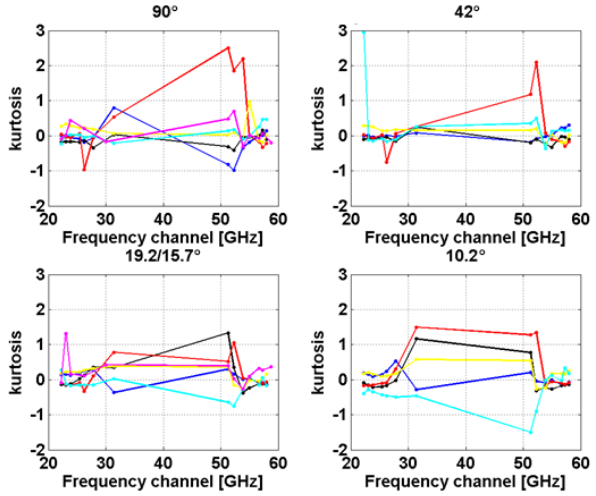
Figure 8. Excess kurtosis as function of frequency for elevation an- gles 90.0, 42.0, 19.2 (15.7 for RAO), and 10.2 ◦ . Scores for JOYCE, LACROS, Payerne, SIRTA, CESAR, and RAO are reported, respec- tively, in blue, black, red, yellow, cyan, and